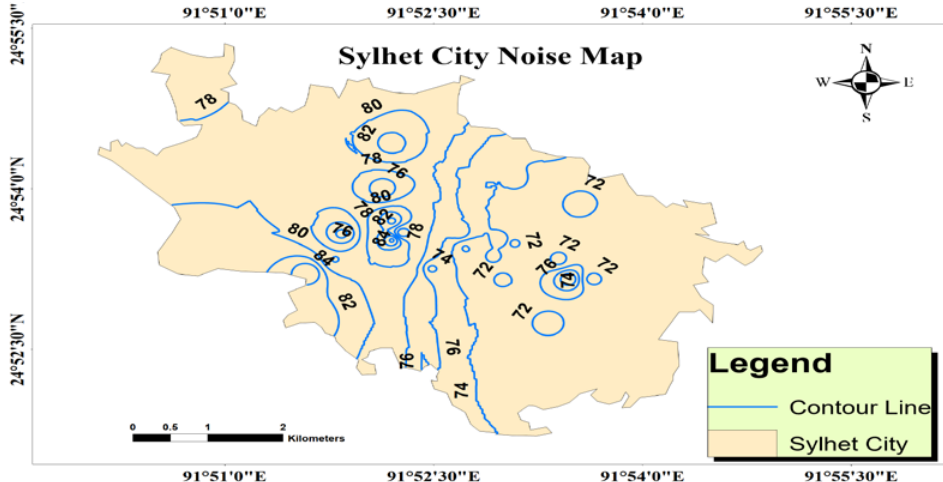
Figure 2. Sylhet City corporation contour noise